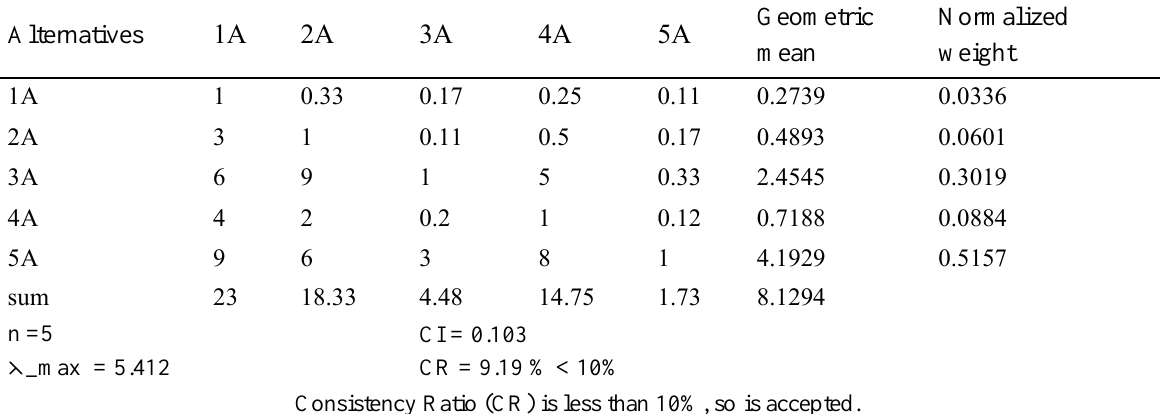
Table 11. Comparison Matrix of Alternatives with Respect to C7.